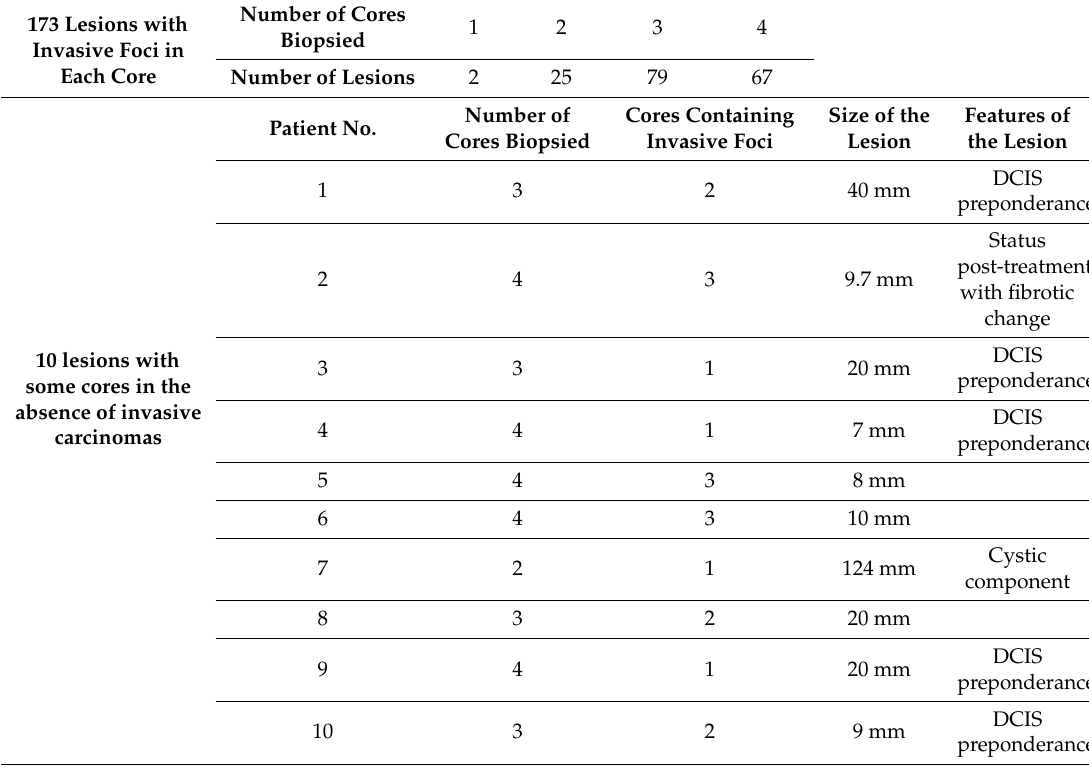
Table 1. Features of 183 invasive lesions biopsied.